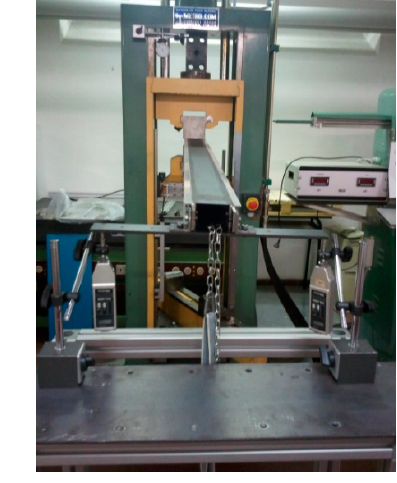
Aerospace 2020 , 7 , x FOR PEER REVIEW